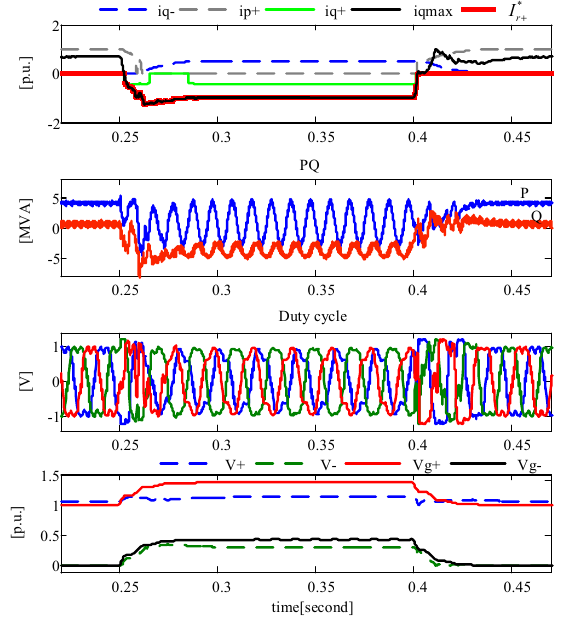
Figure 16. Voltage faults: V ag = 0.5 p.u., V bg = 1.8 p.u., V cg = 1.8 p.u., with anti-saturation for SCR = 5. From top to bottom: in first figure active current reference, reactive current reference and the maximum available reactive current reference; in second figure active and reactive output power of converter; in third figure duty cycle; and in fourth figure magnitude of positive and negative sequence of PCC voltage and grid voltage.